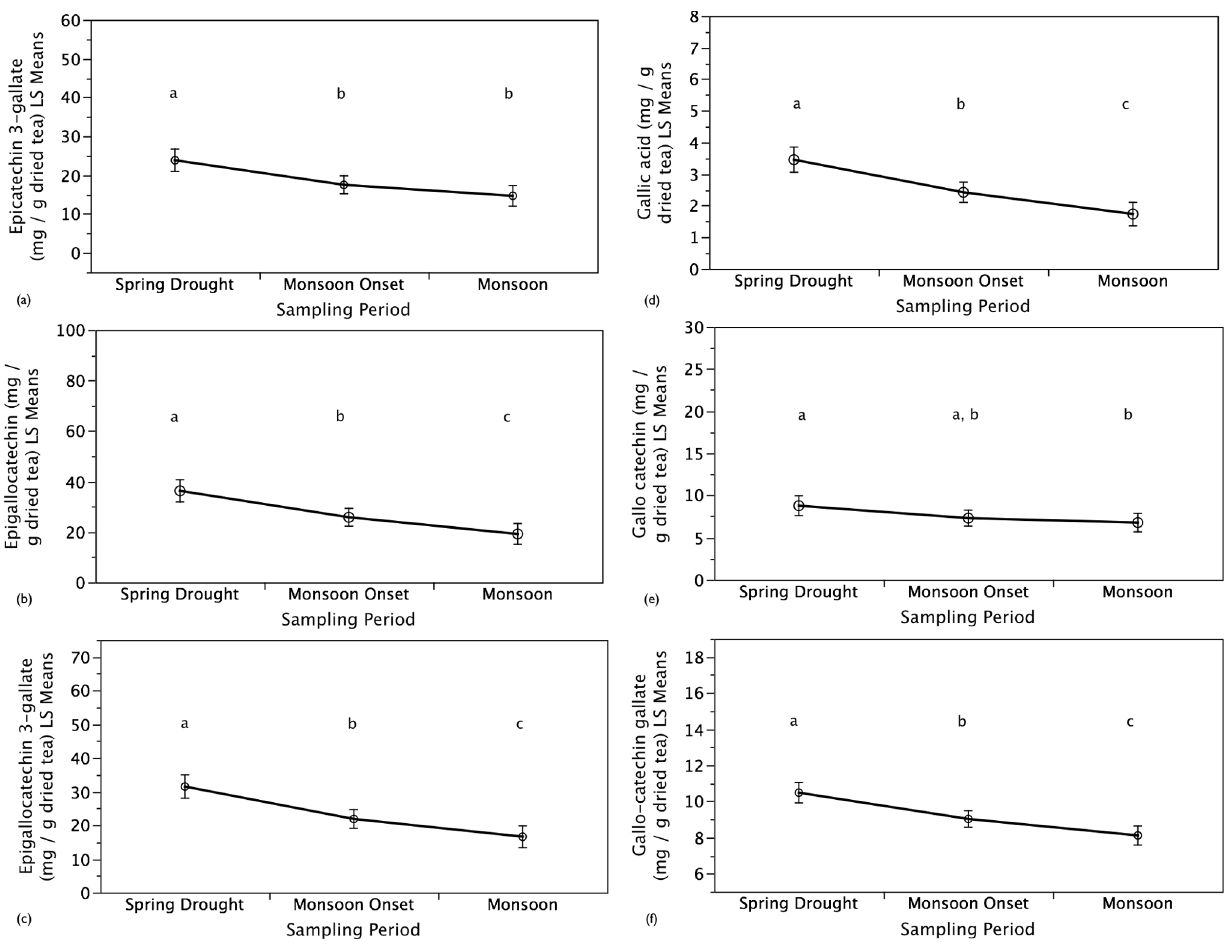
Figure 3. Effects of Precipitation Variability on Tea Polyphenolic Catechins. Increased precipitation from the spring drought to the monsoon tea harvest resulted in significantly lower concentrations of (a) epicatechin 3-gallate (ECG), (b) epigallocatechin 3-gallate (EGCG), (c) epigallocatechin (EGC), (d) gallic acid (GA), (e) gallocatechin (GC), (f) gallocatechin gallate (GCG) as well as catechin (C) and catechin gallate (CG; not shown). Sampling periods not connected by the same letters are significantly different. Values are means 6 one standard error.